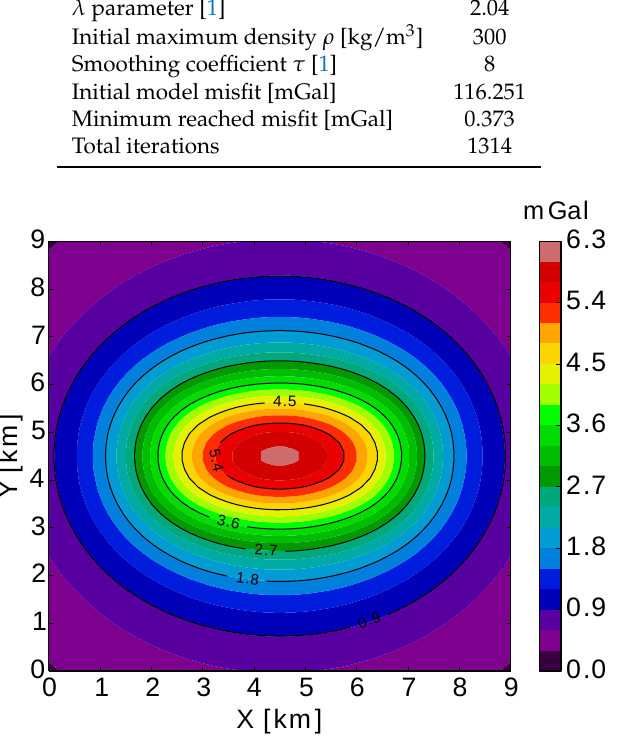
Figure 13. Initial (color map) and inverted (contour lines) gravimetric ( G z ) response for the T